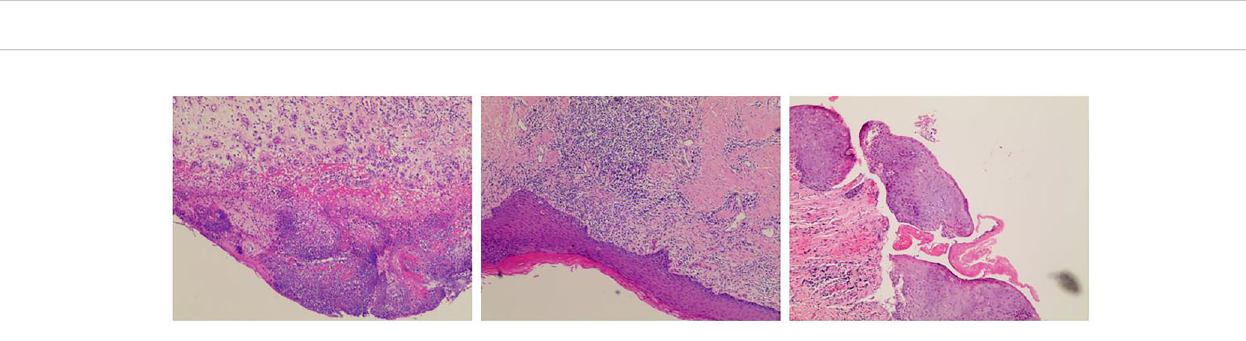
Frontiers in Oncology |